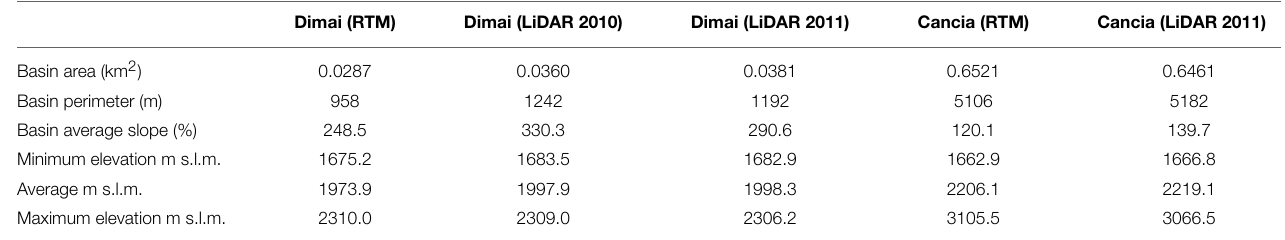
TABLE 1 | Morphometric characteristics obtained by the five different DEMs. Dimai (RTM) Dimai (LiDAR 2010) Dimai (LiDAR 2011) Cancia (RTM) Cancia (LiDAR 2011) Basin area (km 2 ) 0.0287 0.0360 0.0381 0.6521 0.6461 Basin perimeter (m) 958 1242 1192 5106 5182 Basin average slope (%) 248.5 330.3 139.7 Average m